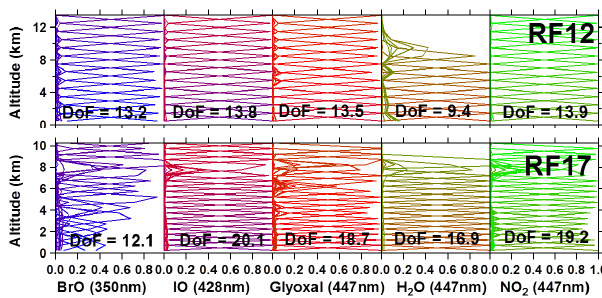
Figure 7. Characterization of the AMAX profiles of BrO, IO, gly- oxal, H 2 O and NO 2 in terms of AVK and DoF for RF12 and RF17. The larger number of DoF during RF17 is the result of a shorter integration time for limb spectra during the aircraft ascent. See Sects. 2.8 and 3.3.